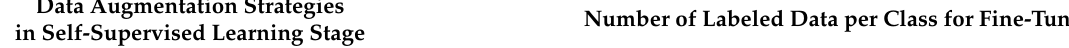
Table 8. The test accuracy (%) of the MsvNetLite with different data augmentation strategies in the self-supervised stage. The (cid:88) denotes this augmentation method is enabled. The bold number is the best result in each